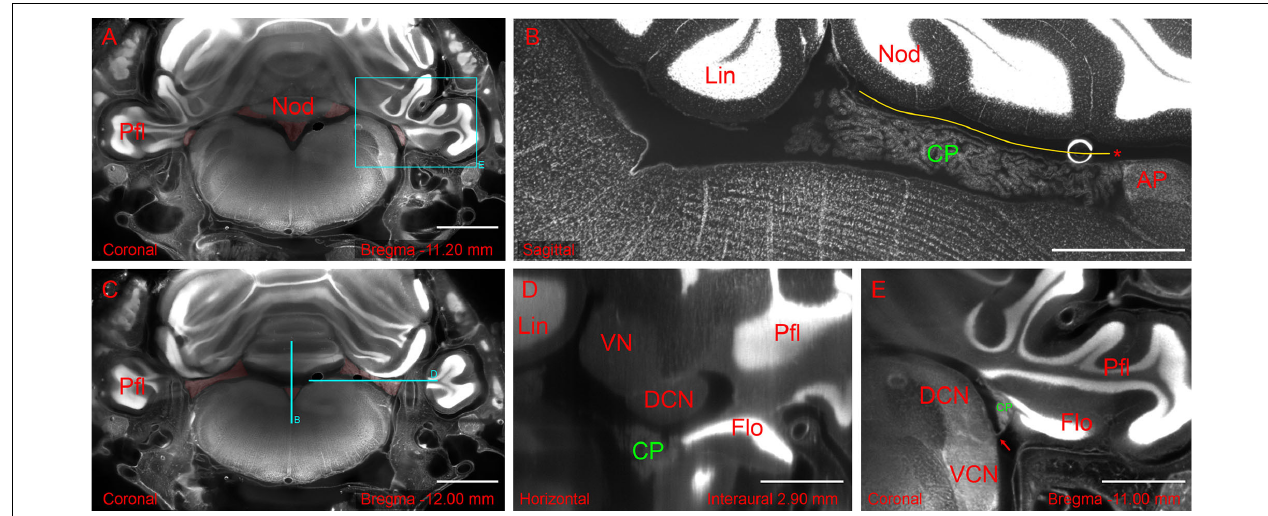
FIGURE 2 | Hindbrain slices from light-sheet 3D dataset of the whole-mount brain-bone preparation showing the extent and association of the CP. (A) Coronal slice showing CP attachment (highlighted in red) at the nodulus and paraflocculus. Scale bar: 2 mm. (B) Sagittal slice (different animal from A ) showing the CSS with overlying tela coroidea (yellow line) and attachment to area postrema (asterisk). Scale bar: 1 mm. (C) Coronal slice showing the MHS (highlighted in red). Same animal as in (A) . Scale bar: 2 mm. (D) Horizontal slice detail (reslice of stack in A,C ) showing the dorsal cochlear nucleus (DCN) and flocculus (FL). Scale bar: 1 mm. (E) Coronal slice detail from animal in (A) showing the foramen of Luschka (arrow) with the associated CP. Scale bar: 1 mm. All sections were stained with TOPRO for cell nuclei. Autofluorescence signal is also visible. Cyan rectangle on panel (A) and cyan lines on panel (C) indicate x , y positions of panels (B,D,E)